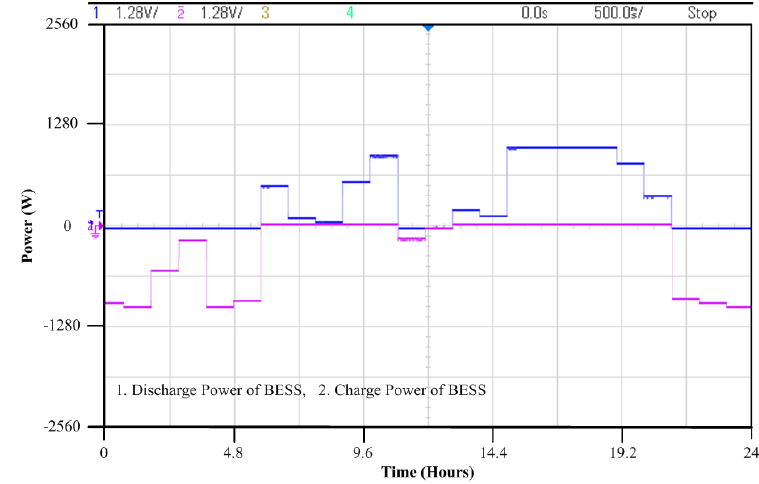
Figure 14. BESS power for scenario-1.